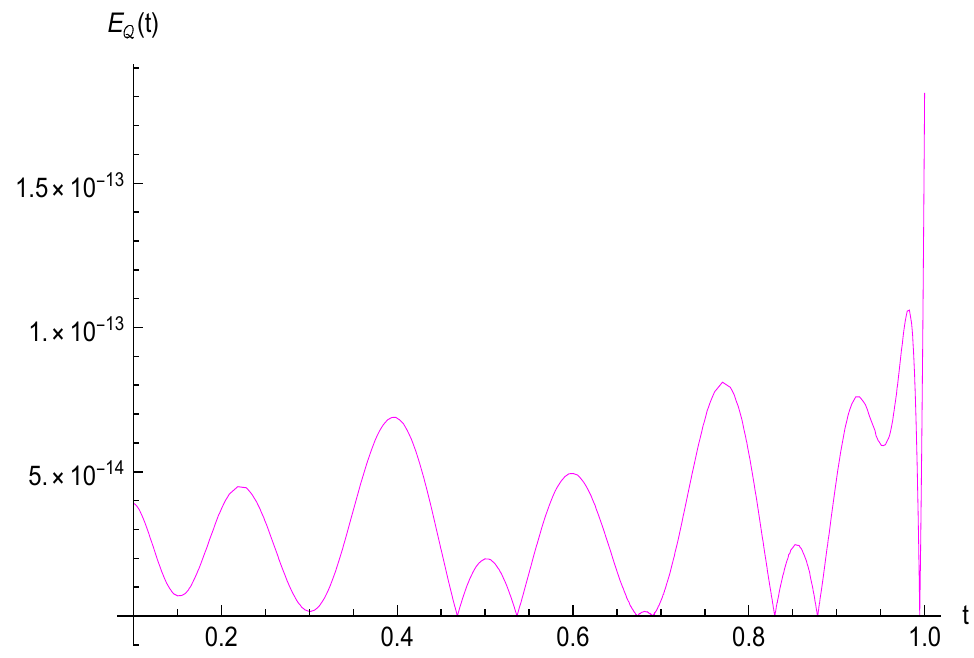
Figure 16. Absolute errors E Q ( τ ) graph of the problem (33), where σ 1 = (cid:36) 1 = σ 2 = (cid:36) 2 = 0, ν = 0.9 and N = M =